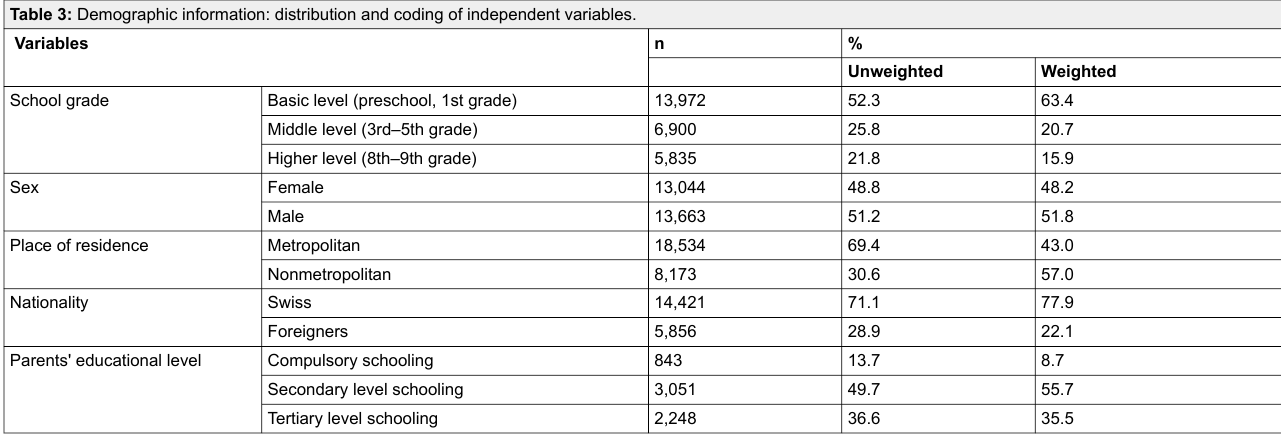
Table 3: Demographic information: distribution and coding of independent variables.